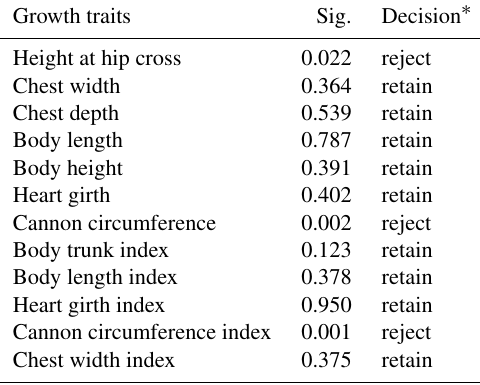
Table 4. Hypothesis test summary for relationship between the genotypes from the 20-bp indel locus of CDC25A gene and growth traits in SBWC goat (Mann–Whitney U